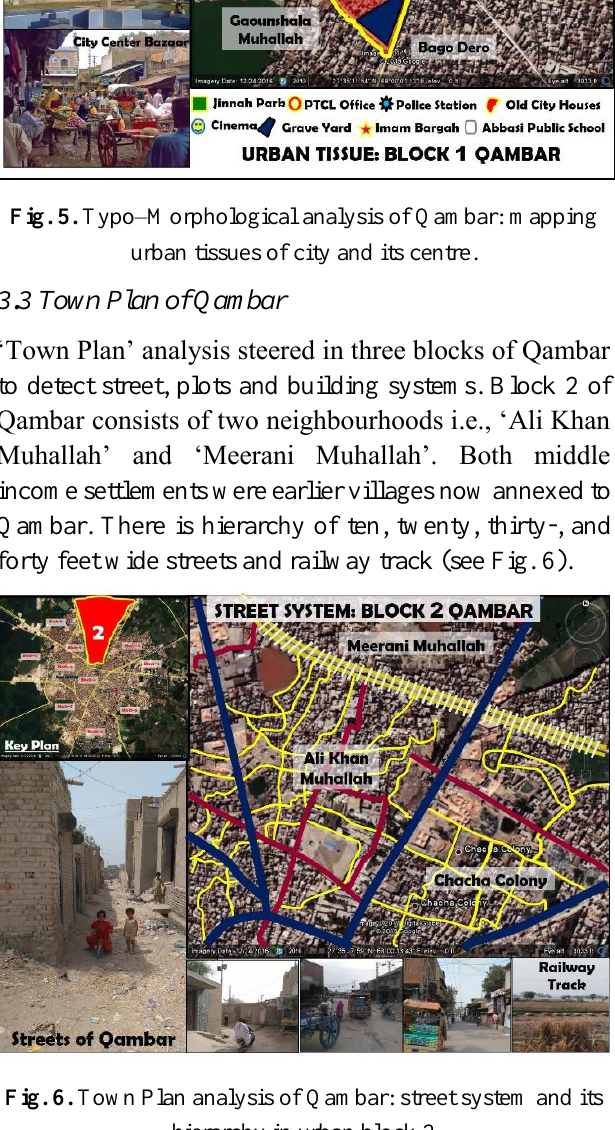
Fig. 6. Town Plan analysis of Qambar: street system and its hierarchy in urban block